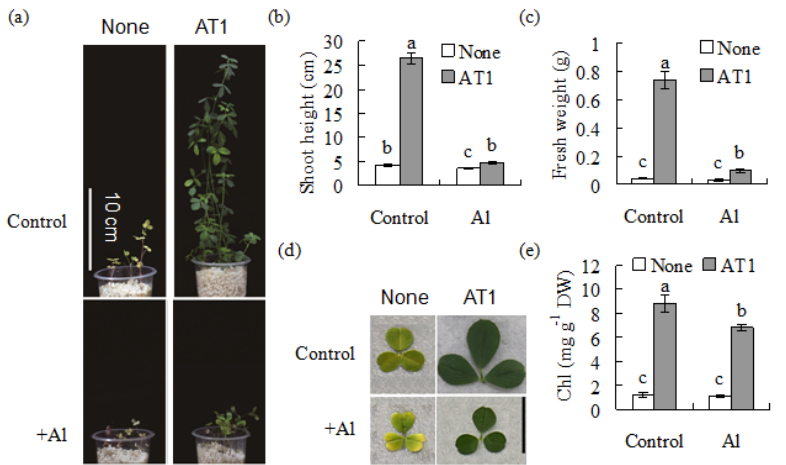
Figure 2. Analysis of the shoot growth in alfalfa, as affected by rhizobia inoculation under Al － stress conditions. An AT1 suspension culture in combination with 1 mM AlCl 3 or without AlCl 3 as a control was rhizospherically applied to seedlings of alfalfa 7 d after germination. The low － nitrogen nutrient was maintained at pH 4.3. The photographs of the plants and leaflets were taken after 5 weeks ( a , d ), followed by measurements of the plant height ( b ), shoot weight ( c ) and chlorophyll concentration in the leaves ( e ). The data are means ± SE ( n = 18); the same letter above the column indicates no significant difference at p < 0.05.